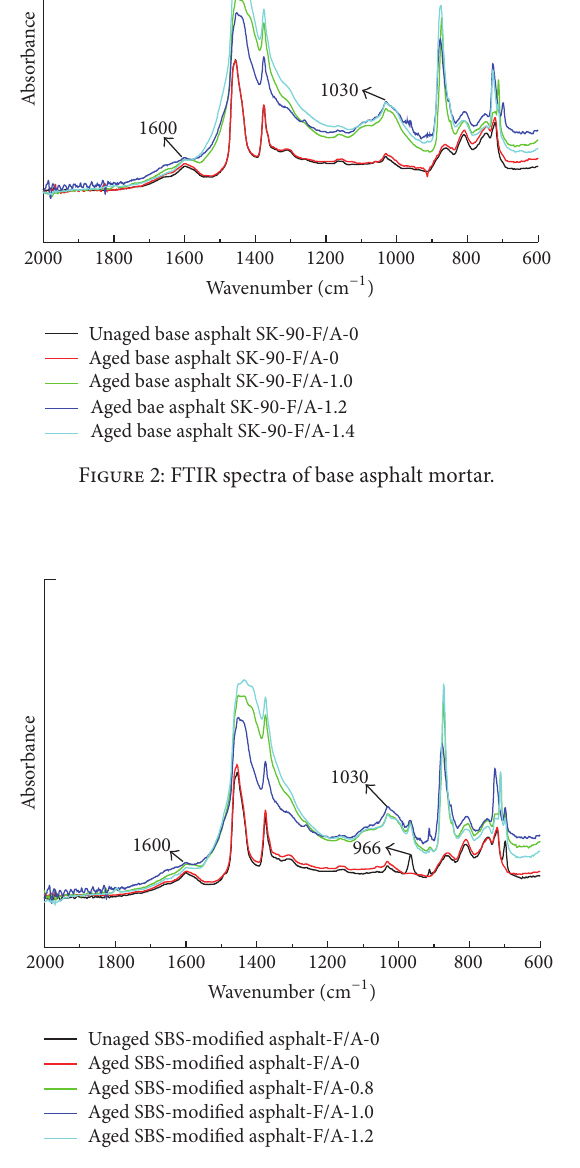
Figure 3: FTIR spectra of SBS-modified asphalt mortar.